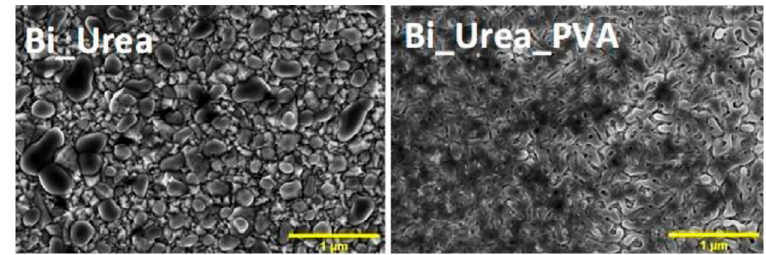
Figure 15. SEM images of Bi_Urea and Bi_Urea_PVA coatings [131].